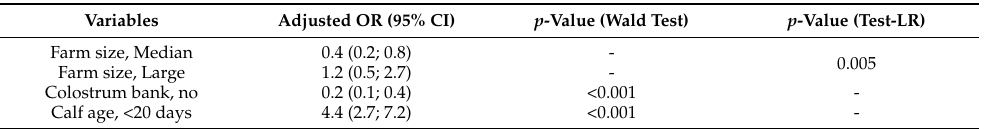
Table 4. Adjusted OD obtained by multiple logistic regression for the independent variable “